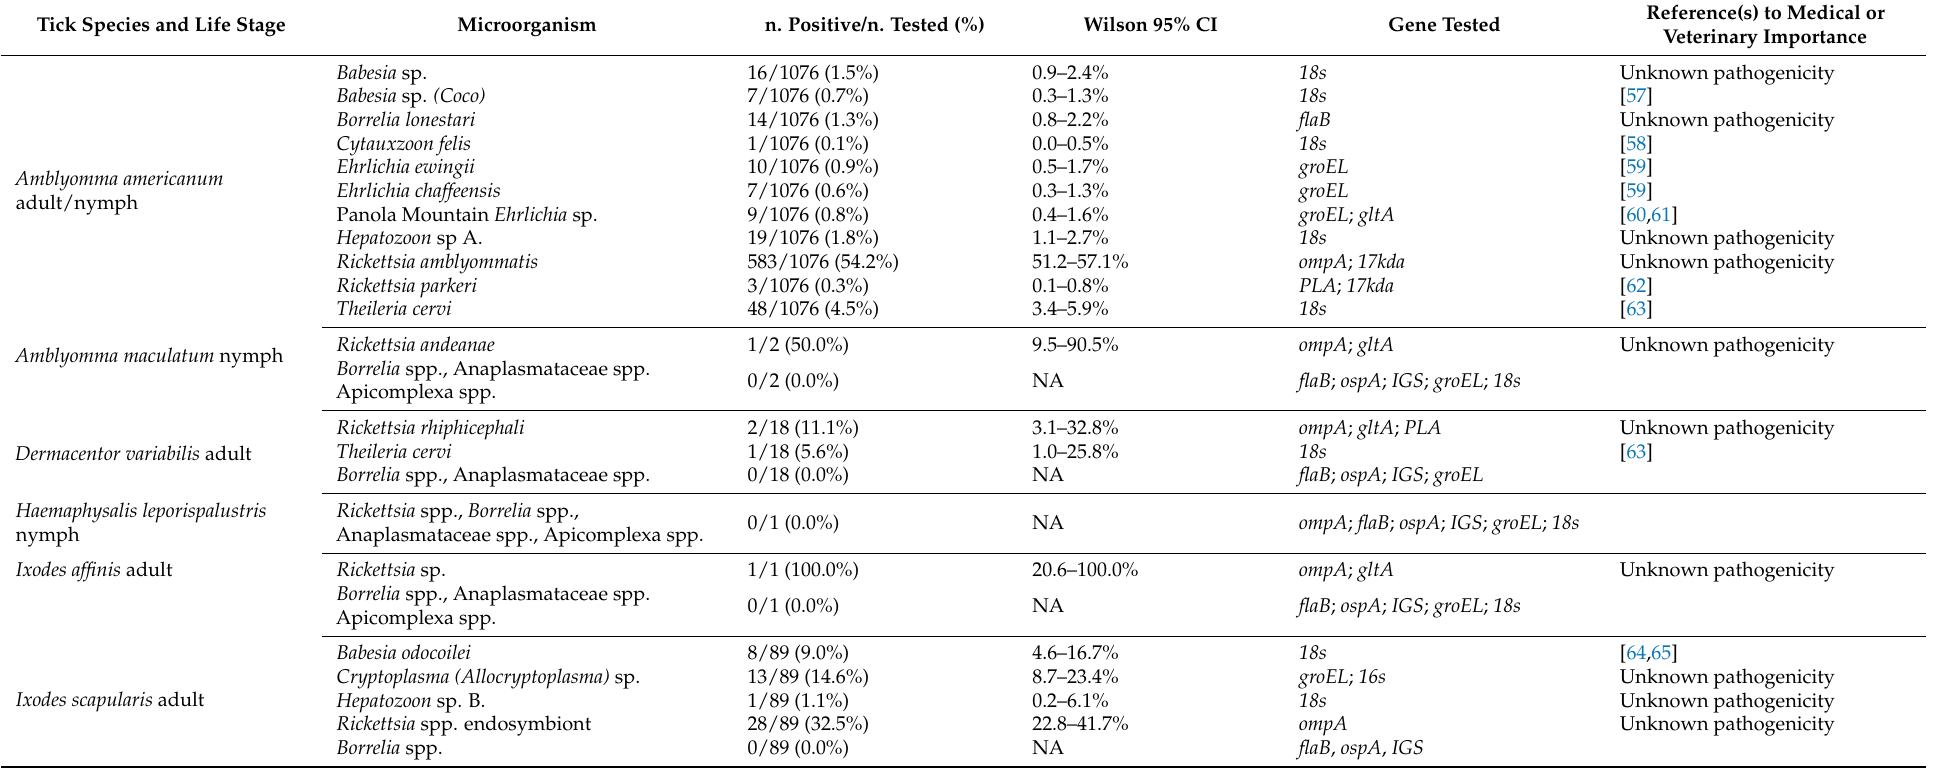
Table 2. Microorganism prevalence in individual nymphal and/or adult ticks collected from January 2021 to June 2021 across 17 greenspaces, in Alachua County, Florida, USA, with Wilson 95% CI and gene information retrieved. A reference is given to distinguish microorganisms of potential or known medical or veterinary importance, or if microorganisms were cited in human and domestic-animal case reports. The abundance of ticks that includes the referenced microorganisms was used as a response variable in the generalized linear model. It is also noted if a microorganism is of unknown